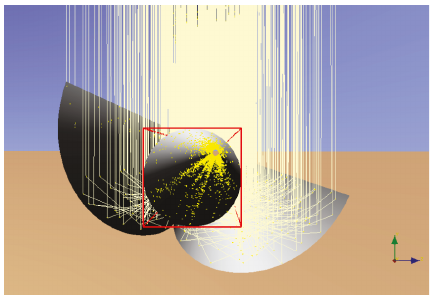
Figure 1: CPC under Tonatiuh ray tracing simulation.